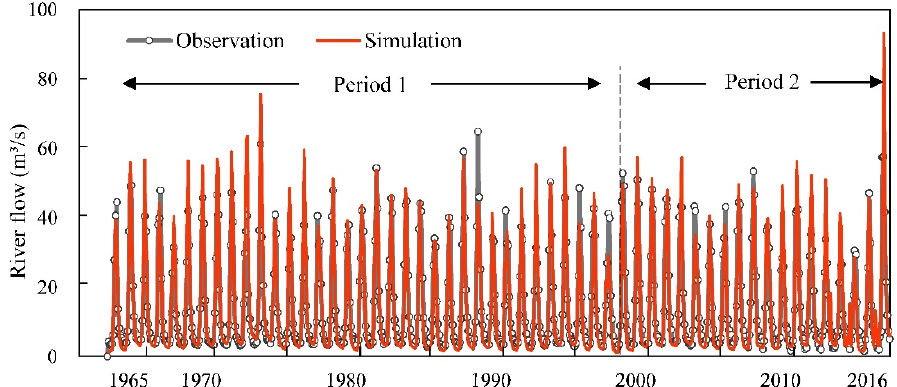
Figure 3. Observed and simulated river flow for the historical periods in the Jinghe River Basin. Table 3. Evaluation indices for assessing performance of the